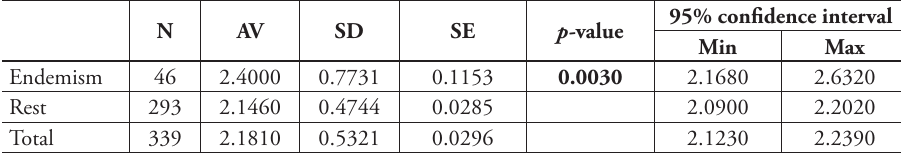
Table 4. t-student analyses by gypsophily level, taxa grouping by endemic and non-endemic species. Number of species (N). Average (AV). Standard deviation (SD). Standard error (SE).